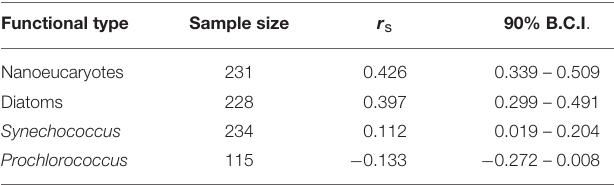
TABLE 1 | Validation results of the PHYSAT-Med dataset with HPLC data from the Ligurian Sea. Functional